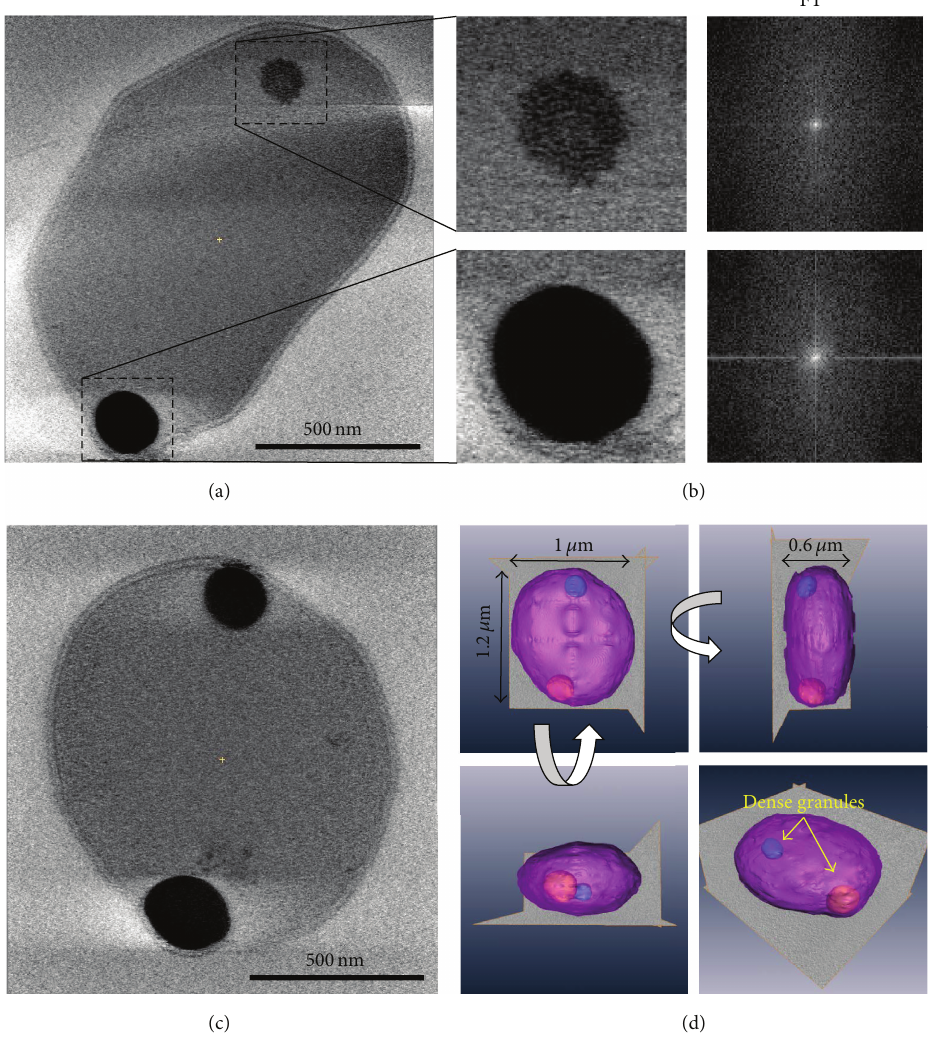
Figure 2: CryoET of A. fulgidus cells reveals dense cytoplasmic bodies. (a) Central slice from a 3D tomogram reconstructed from a cryoET tilt series of a whole cell frozen in vitreous ice. (b) The two granules present in (a) are enlarged to show their amorphous features. The Fourier transform of each granule is shown on the right. (c) Central slice from the 3D tomogram of another cell. (d) 3D rendering of the cell in (c) shown from different angles. The cell is shown in pink, the 2 granules are shown in blue and yellow, and the dimensions of the cell are